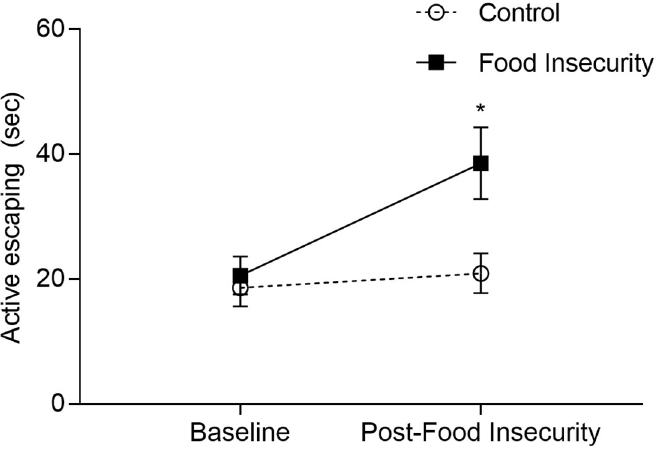
Fig 2. Effect of food insecurity on time spent actively coping in forced swim test (mean +/-SEM). An interaction was observed between group and time, such that mice exposed to food insecurity increased their active escaping behavior, while controls did not (repeated measures two-way ANOVA, group x time interaction: F 1,63 = 5.40, P = 0.023). � P < 0.05.